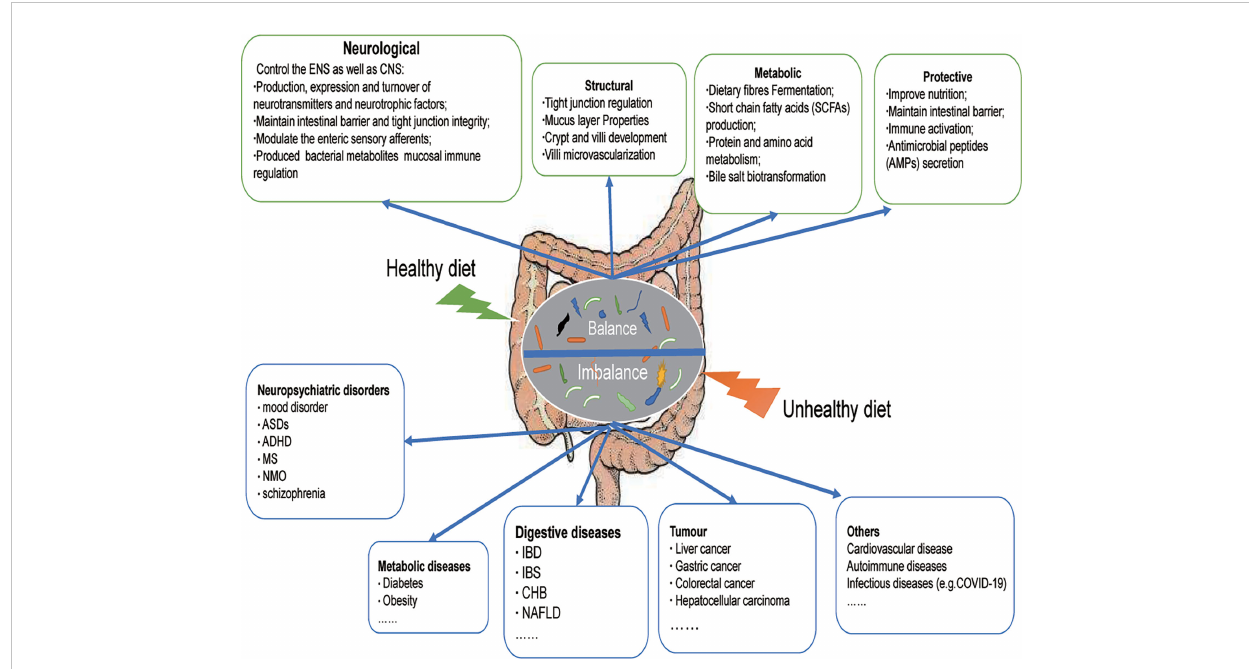
FIGURE 1 Dietary modulation of the gut microbiota. A healthy diet can maintain the balance of intestinal microecology, and is bene fi cial for the gut microbiota to exert positive effects on the host (neurological, structural, metabolic, protective). An unhealthy diet disrupts the balance of the host gut microecology and participates in the occurrence and development of many diseases, including neuropsychiatric disorders, metabolic diseases, digestive diseases, tumor, and others. ASDs, Autistic Spectrum Disorder; ADHD, Attention de fi cit and hyperactivity disorder; MS, Multiple Sclerosis; NMO, neuromyelitis optica; IBD, In fl ammatory bowel disease, IBS, Irritable Bowel Syndrome; CHB, Chronic hepatitis B; NAFLD, Nonalcoholic fatty liver